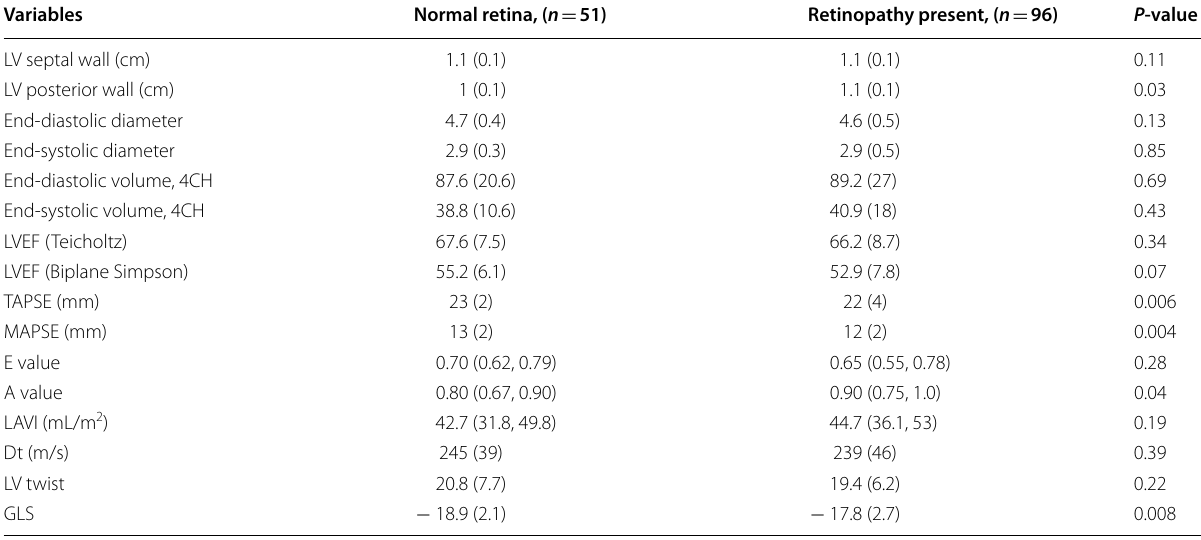
Continuous variables are presented as mean and standard deviation (SD) LV, Left ventricle; 4CH, Four-chamber; LVEF, Left ventricle ejection fraction; TAPSE, Tricuspid annular plane systolic excursion; MAPSE, Mitral annular plane systolic excursion; LAVI, Left atrial volume index; Dt, Deceleration time; GLS, Global longitudinal strain